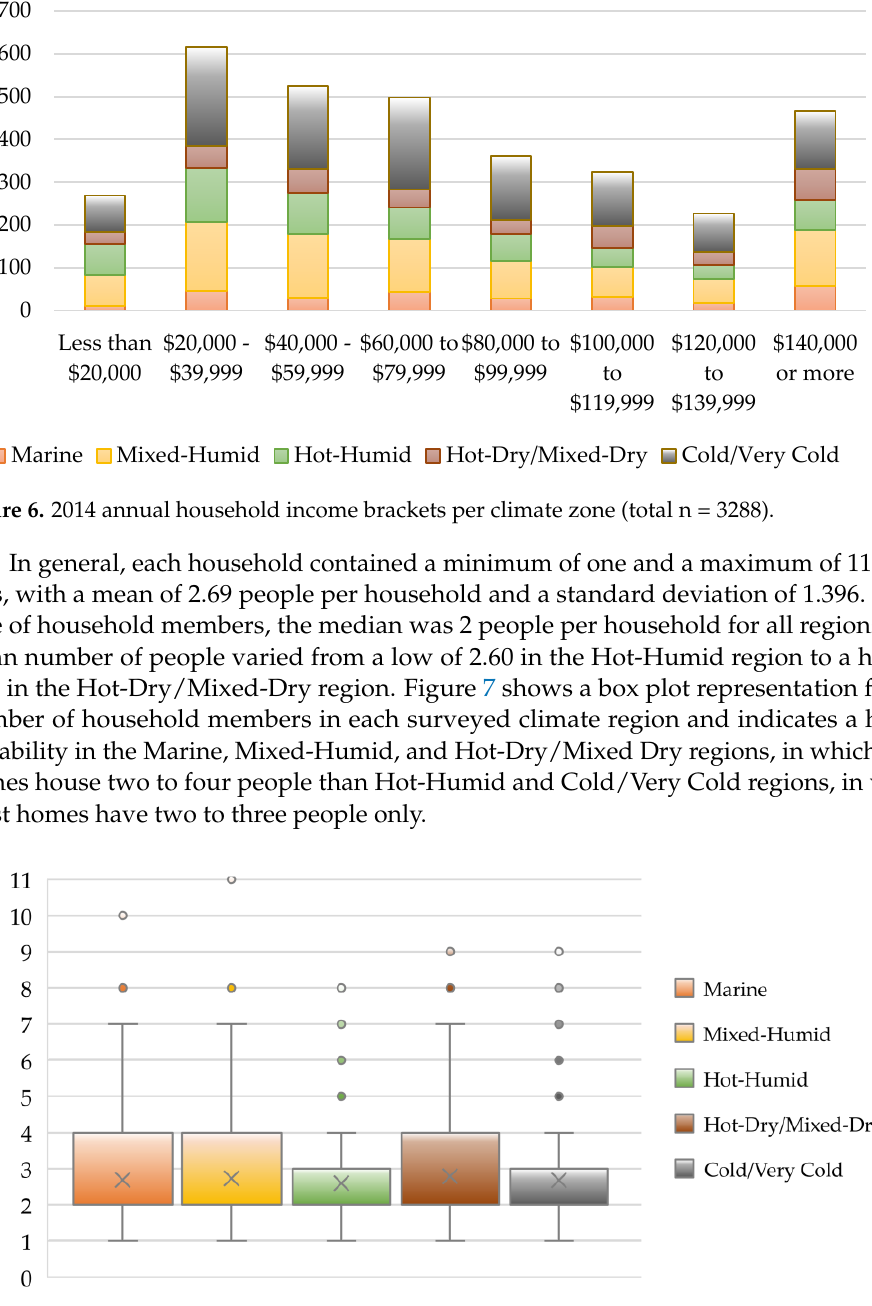
Figure 7. Box plot for the number of household members per climate region.